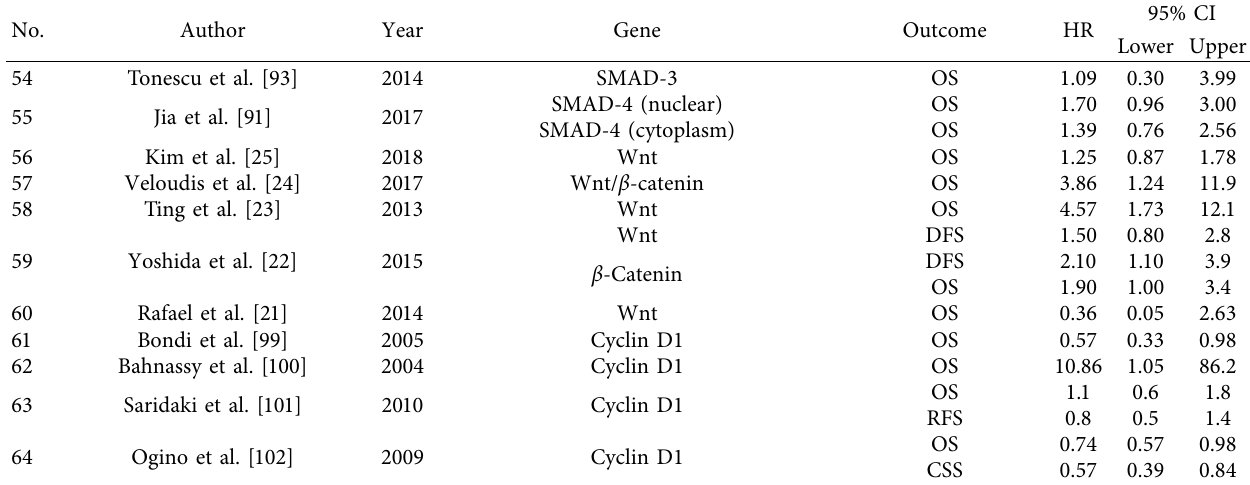
The table represents 105 data points on genes where HR data were available. OS: overall survival, RFS: relapse-free survival, CFS: cancer-free survival, DFS: disease-free survival, PFS: progression-free survival, CRC risk: colorectal cancer